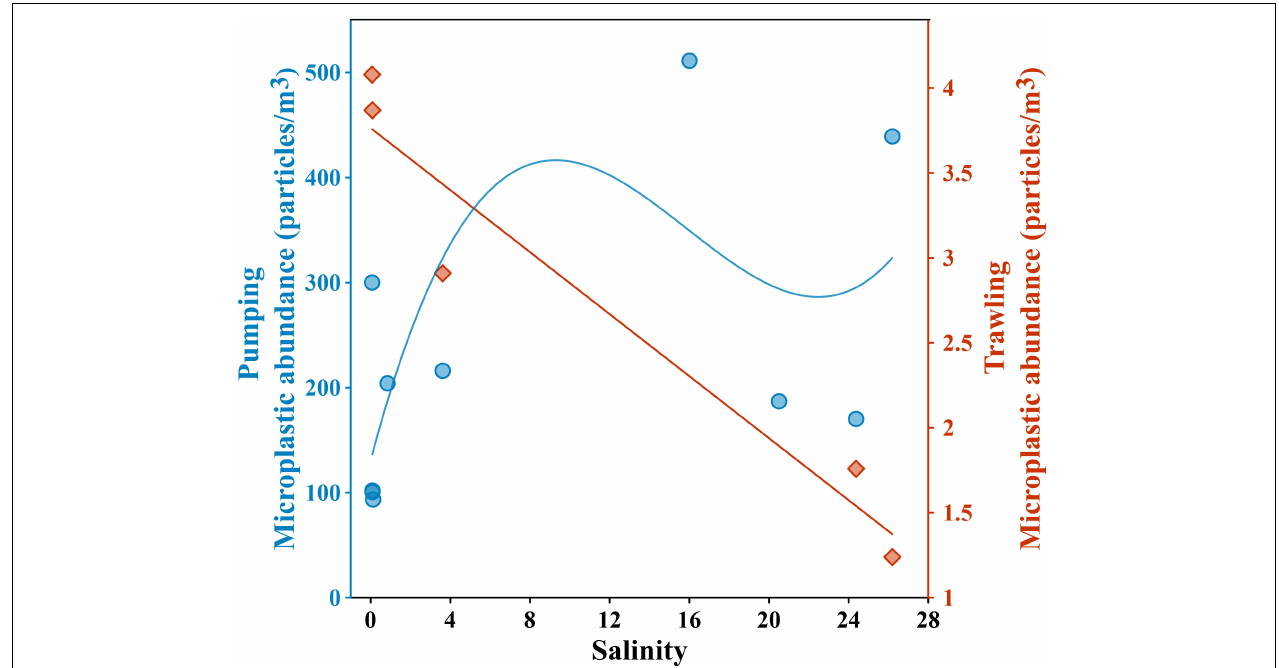
FIGURE 3 | The relationship between the abundance of microplastics and the salinity of the water from which they were sampled in the Jiulong River Estuary. The red squares refer to the large particles that were collected by trawling, and the blue dots refer to the small particles that were collected by